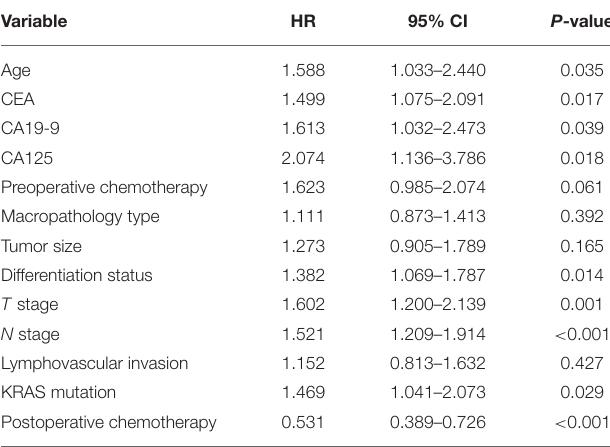
TABLE 3 | A multivariate Cox regression analysis for OS of the training